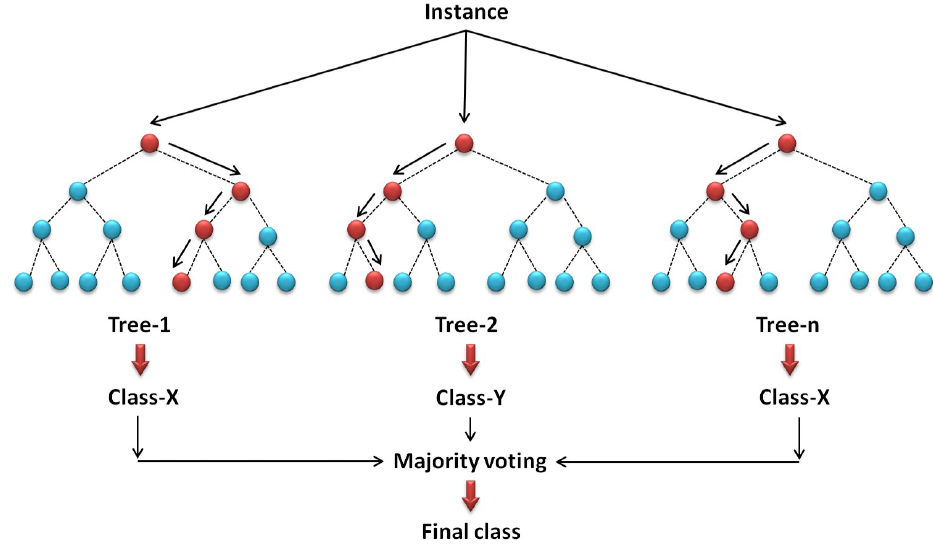
Figure 5. The general framework of the random forest (RF) approach [63]. In our case, 1000 trees and five variables were selected after testing di ff erent settings which could not improve the results any